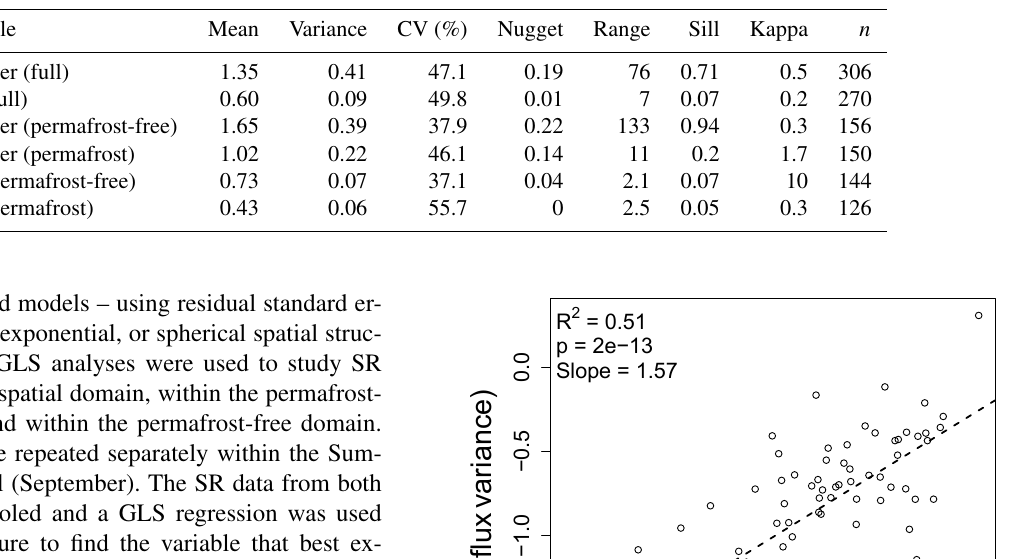
Table 1. Soil respiration summary statistics, Matern variogram parameters, and sample sizes (n) for each season across the full, permafrost- free, and permafrost-associated spatial domains.